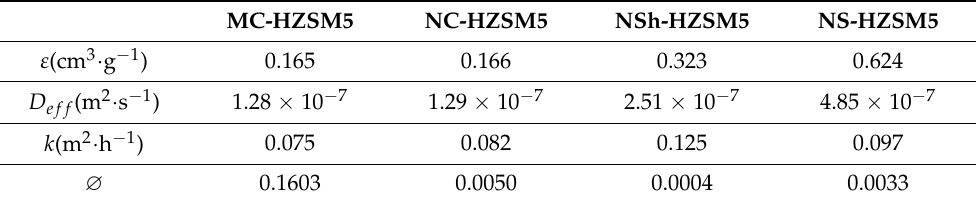
Table 3. Thiele modulus for triglycerides transesterification using MC-HZSM5, NC-HZSM5, NSh- HZSM5, and